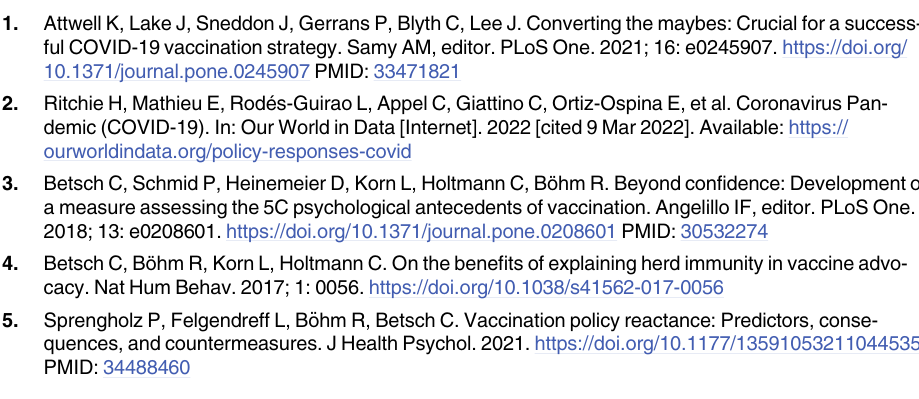
S1 Table. Determinants of getting vaccinated. S2 Table. Determinants of getting vaccinated with and without monetary incentive. S3 Table. Determinants of minimum required monetary